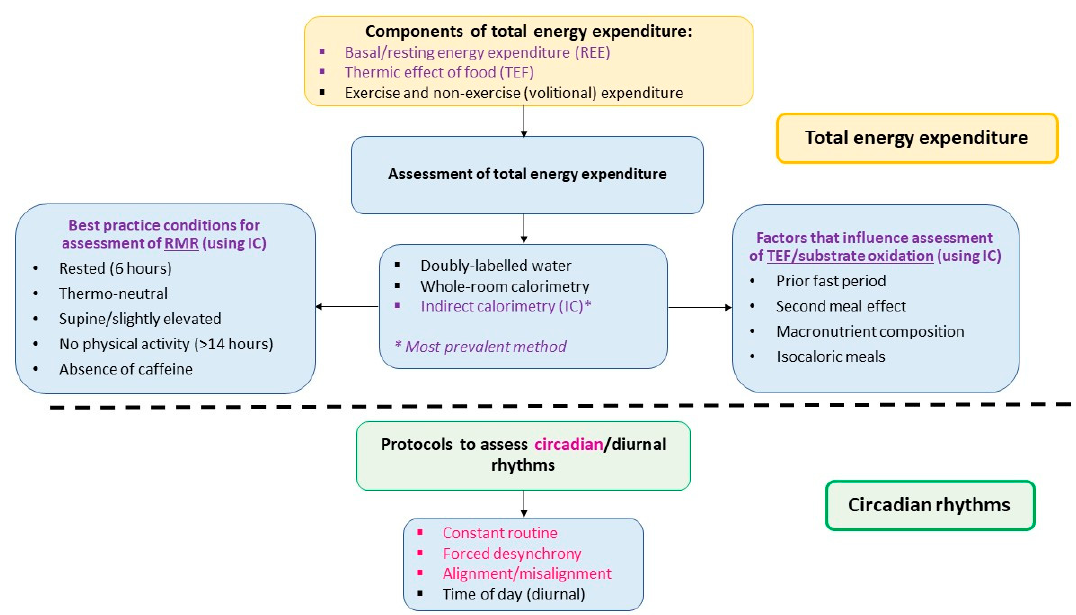
Figure 2. Conditions required to assess the existence of diurnal / circadian rhythms in energy